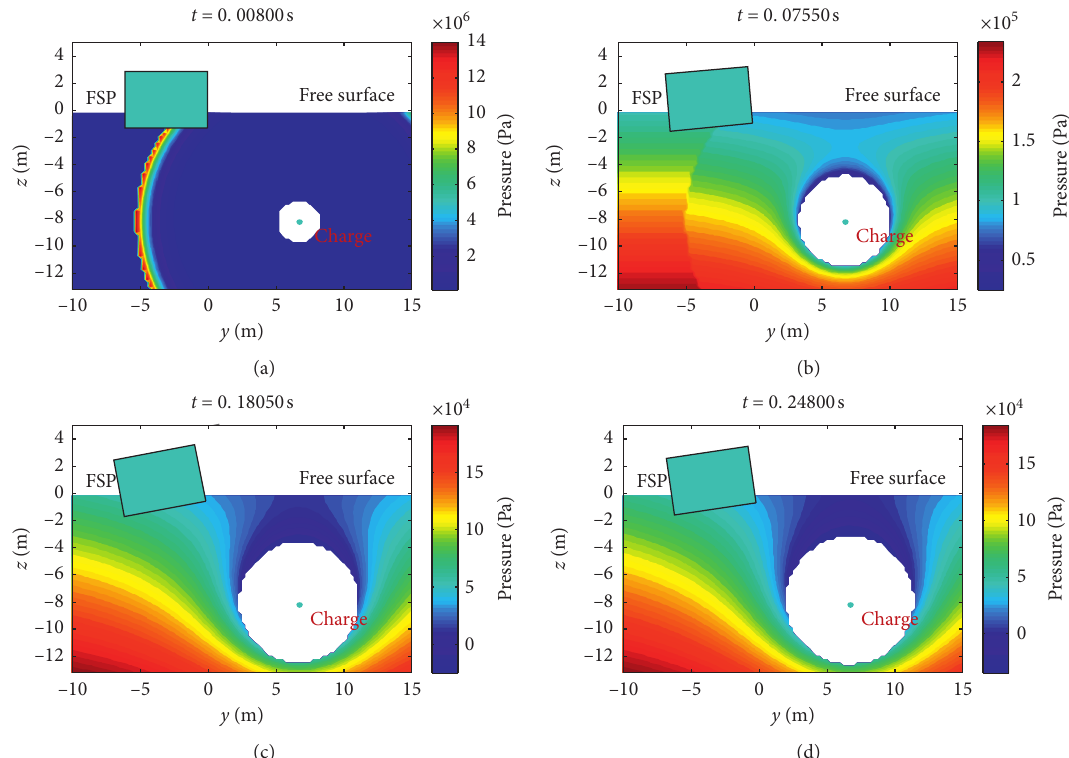
Figure 2: Rigid motion of platform under underwater explosion load. (a) t � 0.008s. (b) t � 0.0755s. (c) t � 0.1805s. (d) t � 0.2480s.